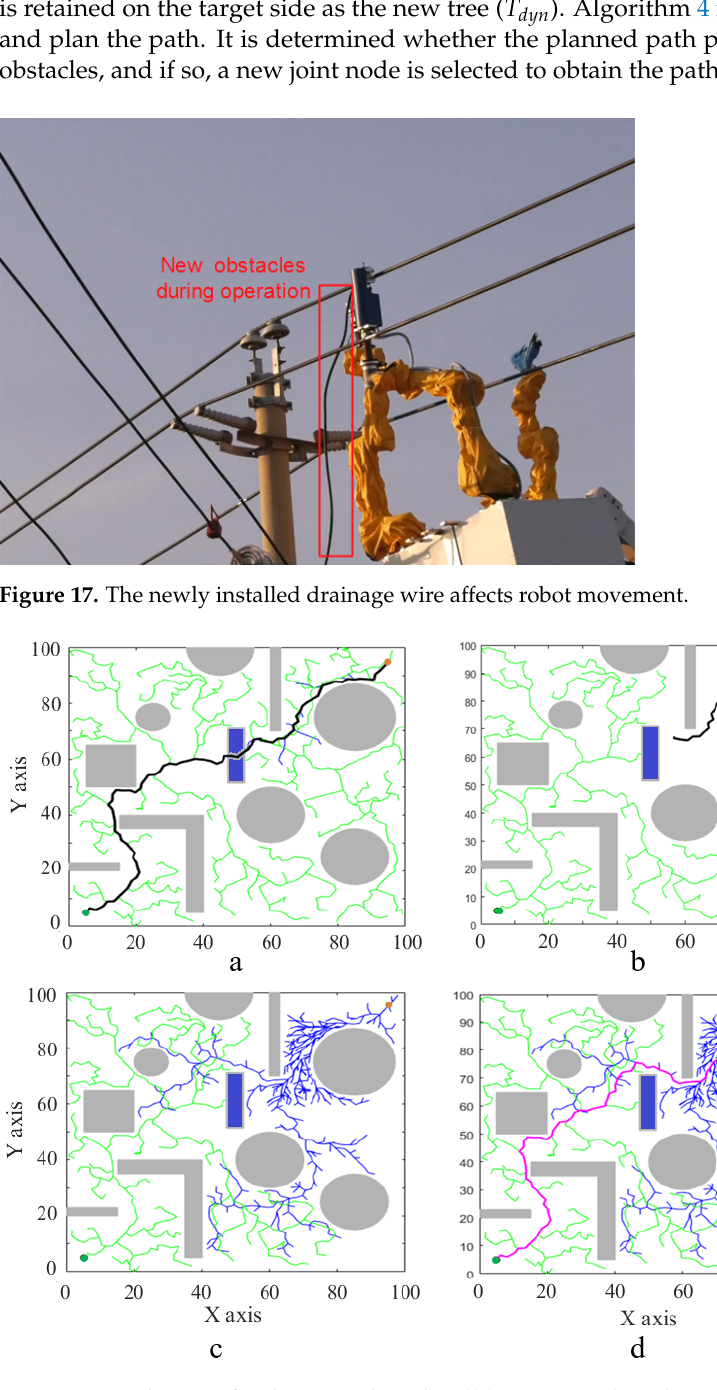
Figure 18. Replanning for dynamic obstacles. (( a ) Dynamic obstacles appear on the planned path, ( b ) cut T of fline according to the obstacle position, and ( c ) expand T dyn from the left path (black part in ( b )), ( d ) a new path is selected to avoid dynamic